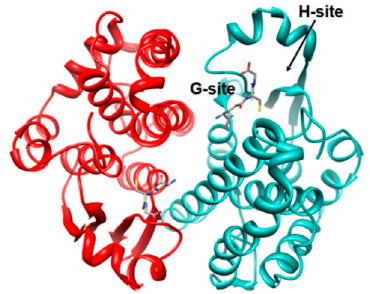
Figure 1. Structure of glutathione transferase P1-1 (GSTP1-1). GSTP1-1 (also referred: erythrocyte glutathione transferase) (PDB id: 6gss) [5] . The two monomers are in light-sea-green and red ribbons.